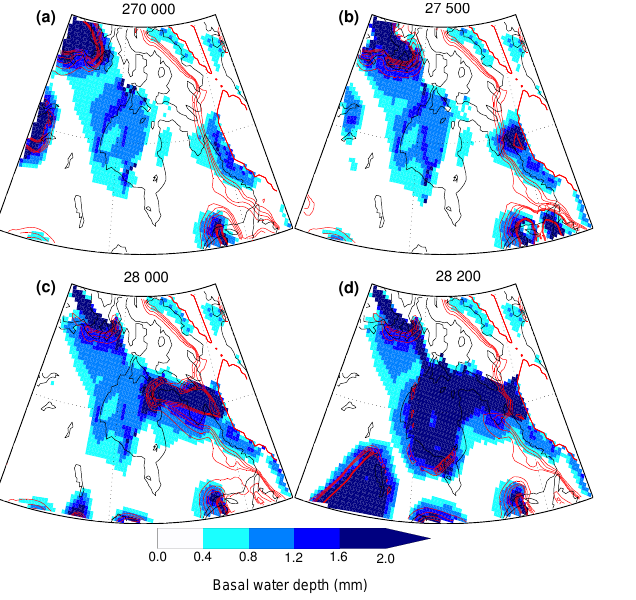
Figure 7. Time slices of the vertically averaged velocity field taken at (a) 27000 years, (b) 27500 years, (c) 28000 years and (d) 28200 years. The times shown are the same as those in Fig. 5. Note that the colours are plotted on a logarithmic